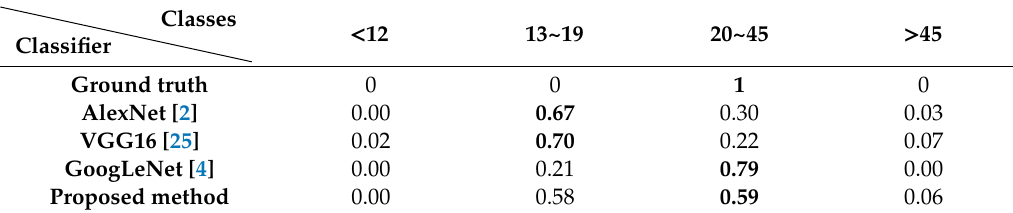
Figure 13. An example photo from the CACD2000 database. Table 17. Recognition results of the Morph Table 18. Recognition results of the CACD2000 photo.